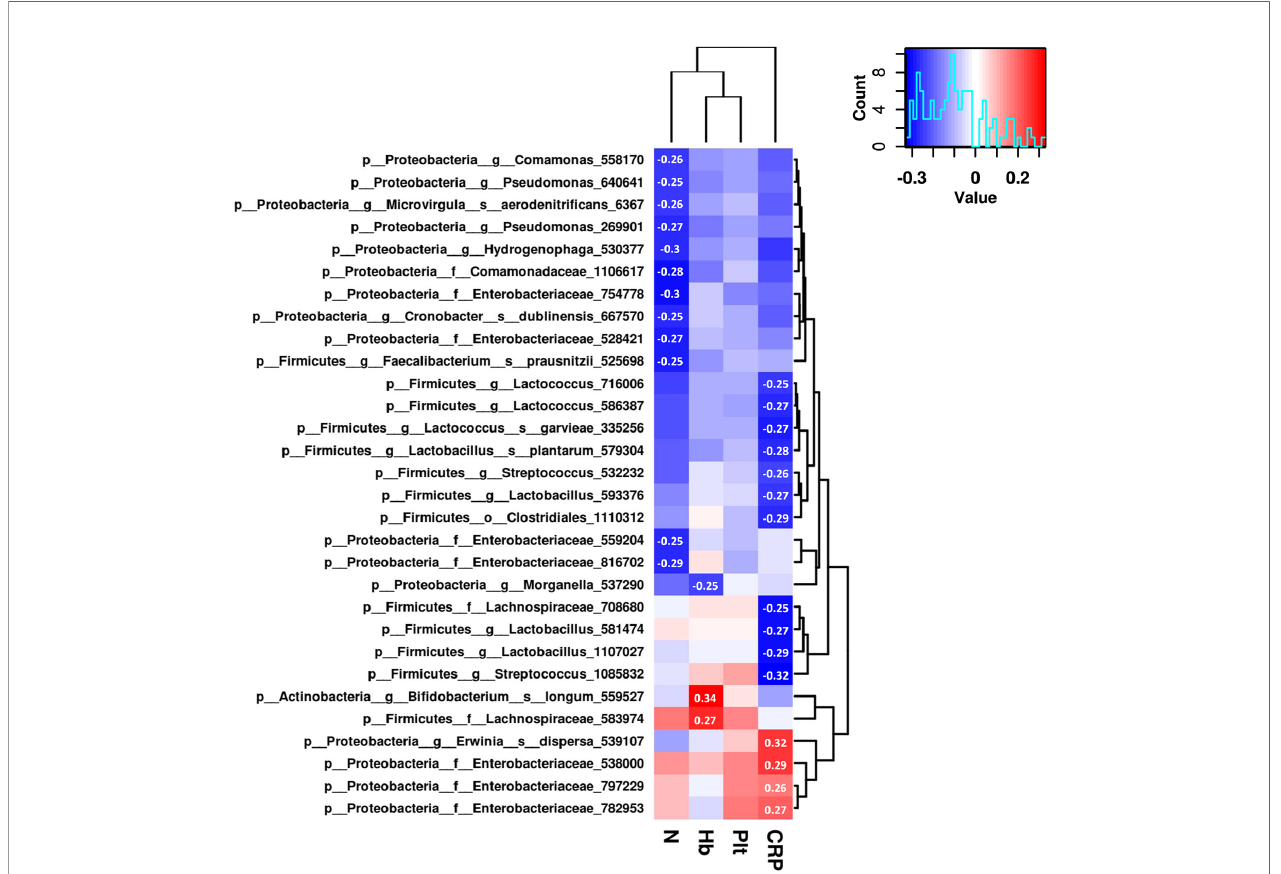
FIGURE 4 | The correlation heat map shows correlations between clinical indices and the relative abundance of genera. Correlation coef fi cients with absolute values higher than 0.25 are shown in the